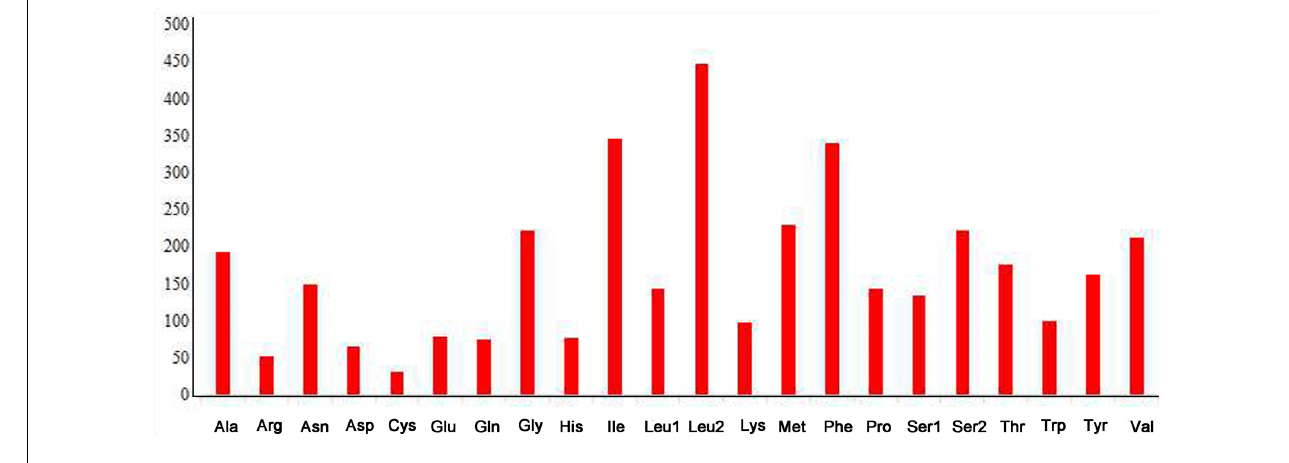
FIGURE 3 | Amino acid composition of the P . bidens mitogenome.